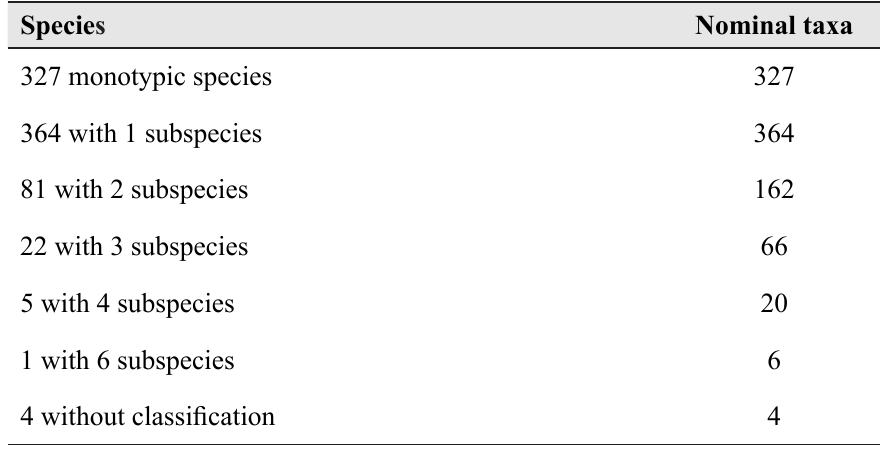
Table 2. Summary of the bird species and subspecies found in Oromia. The species without subspe- cific assignment are Columba livia Gmelin, 1789, Sylvia borin (Boddaert, 1783) , S. nisoria (Bechstein, 1795) and Chalcomitra hunteri (Shelley, 1889)